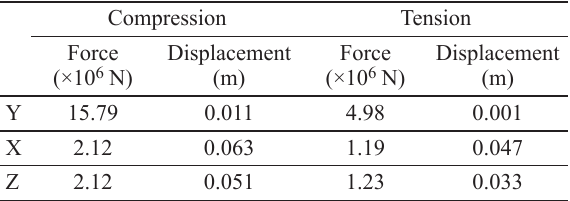
Table 2. Force vs. displacements for design